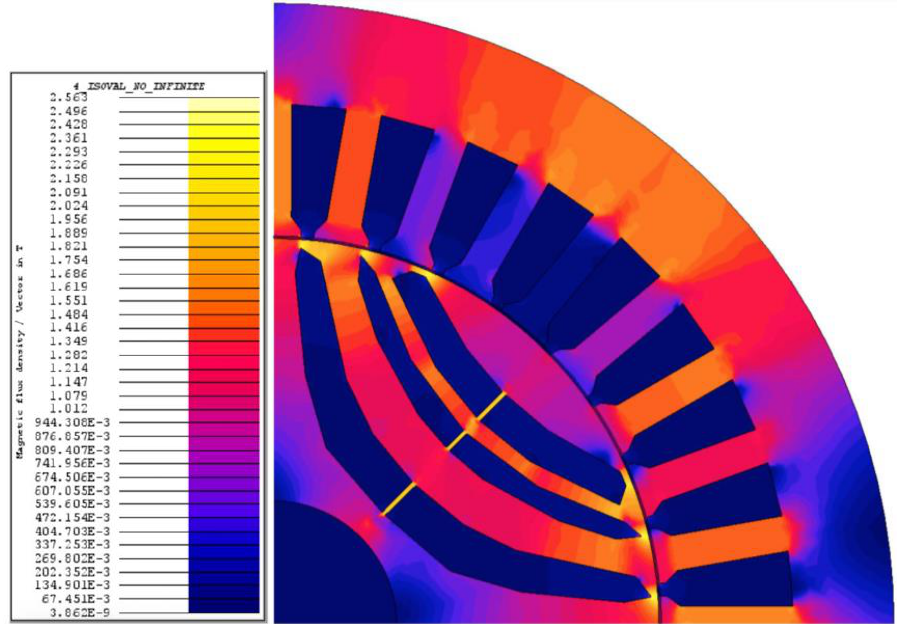
Figure 11. Flux density distribution color map of the best configuration chosen (with sharp-edged barriers). The numerical values written on the right correspond to the colors which represent the magnetic flux density in the different zones of the machines and are expressed in Tesla (T).